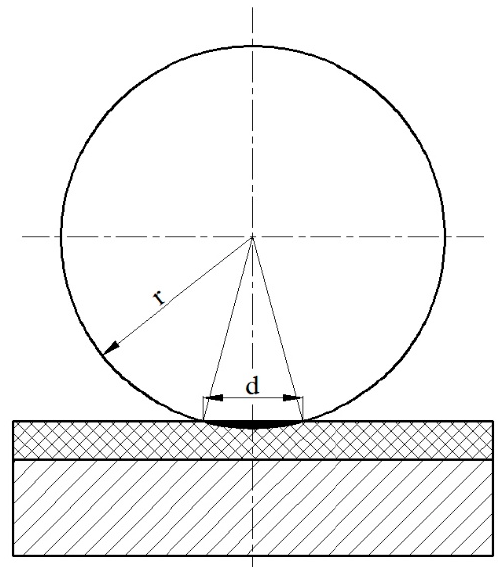
Figure 1. The calculation mode of specific wear rate of ball.